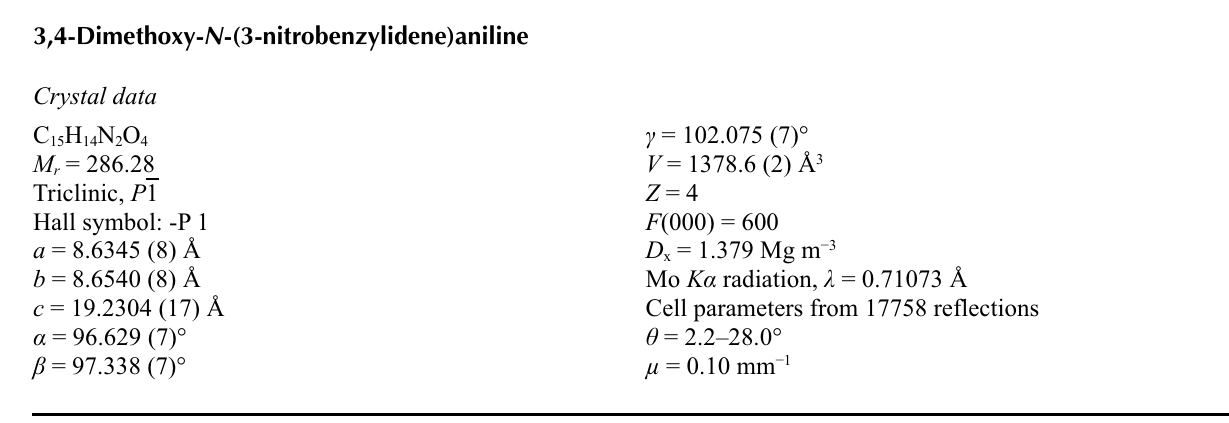
The packing and hydrogen contacts of (I) in the unitcell, down a axis. H atoms not involved in hydrogen bonding have been omitted, for